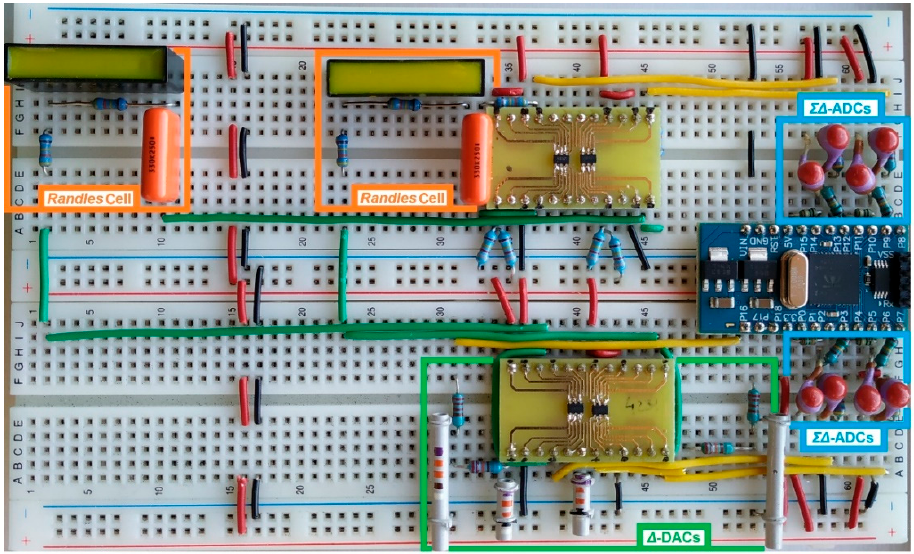
Figure 18. Two-channel prototype photograph.